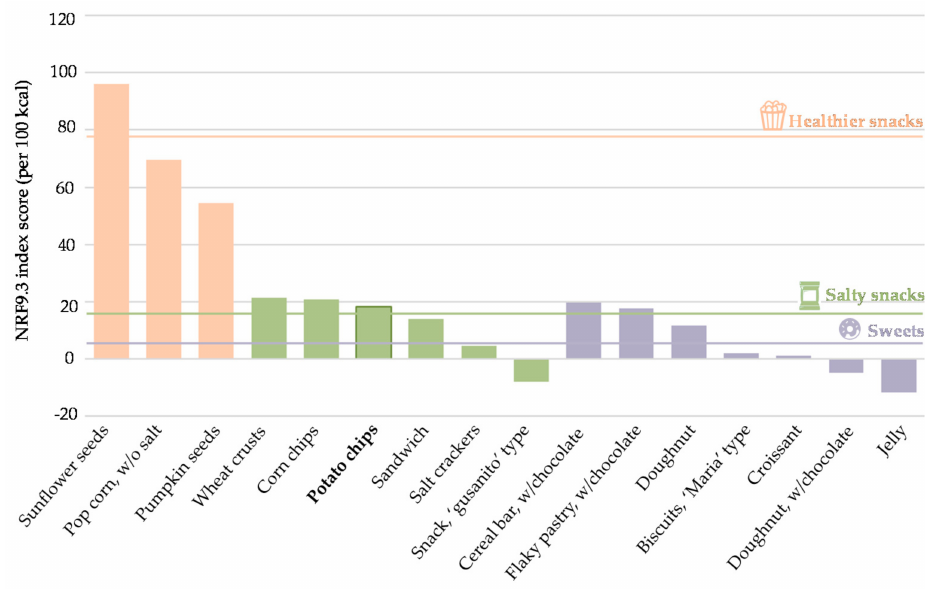
Figure 5. NRF9.3 index scores for different snack options. Bars represent the NRF9.3 for each food, while horizontal lines show the average NRF9.3 for healthy, salty and sweet